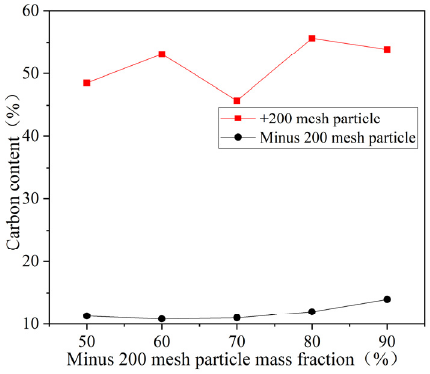
Figure 6. Carbon content of raw fraction carbon dust.